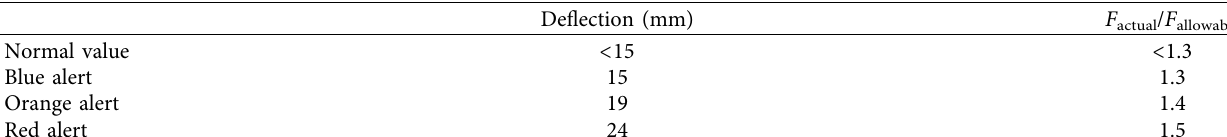
Table 2: Warning value of deflection and cable force.